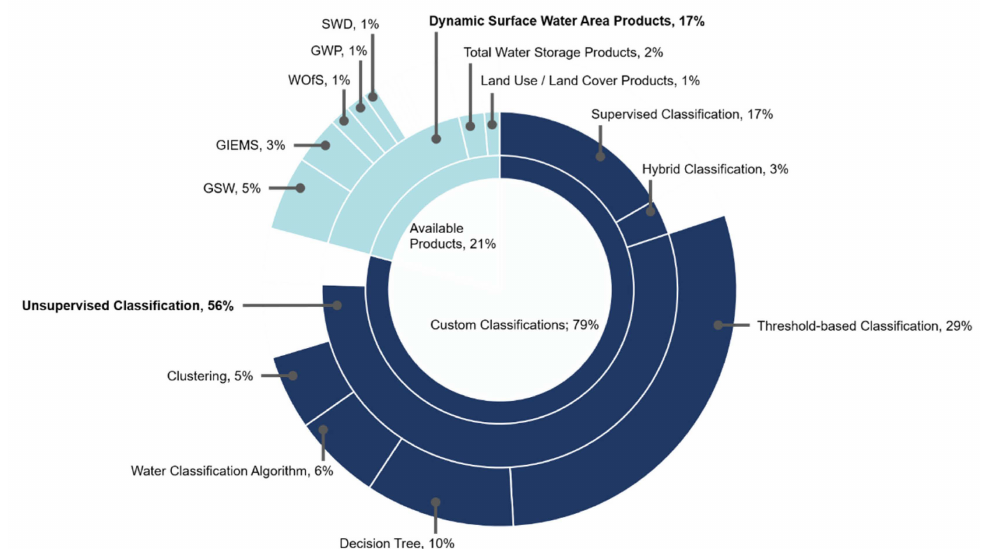
Figure 8. Detailed summary of methods used for the analysis of surface water dynamics. Custom classification approaches and approaches based on available products are shown in dark blue and light blue, respectively. The percentage value represents the share of all included works. All works are sorted as specifically as possible. Methods belonging to multiple subgroups or with too little detail to sort them correctly are not categorized